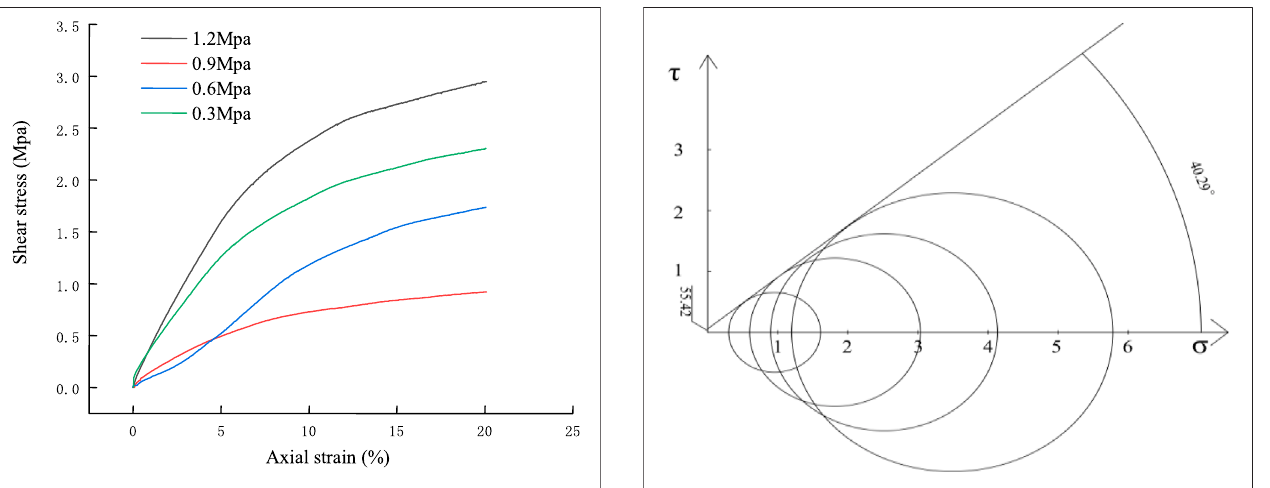
FIGURE 9 | Mohr circle of stone slag and sand mixture diagram.